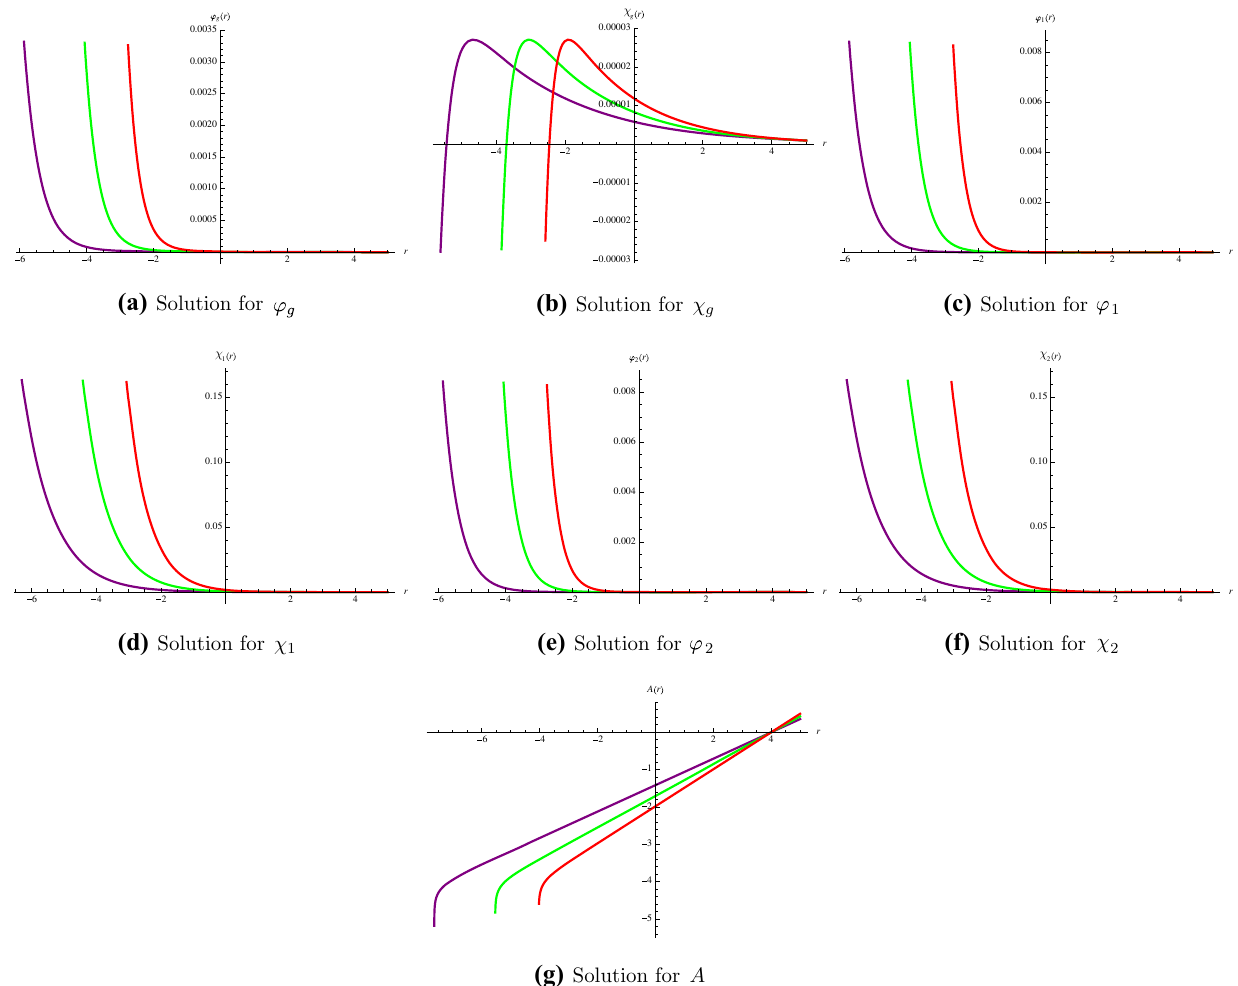
Fig. 2 N = 1 RG flow solutions from type IIB compactification with all SO ( 3 ) singlet scalars and λ = 1 ( purple ), λ = 1 . 2 ( green ) and λ = 1 . 4 ( red )